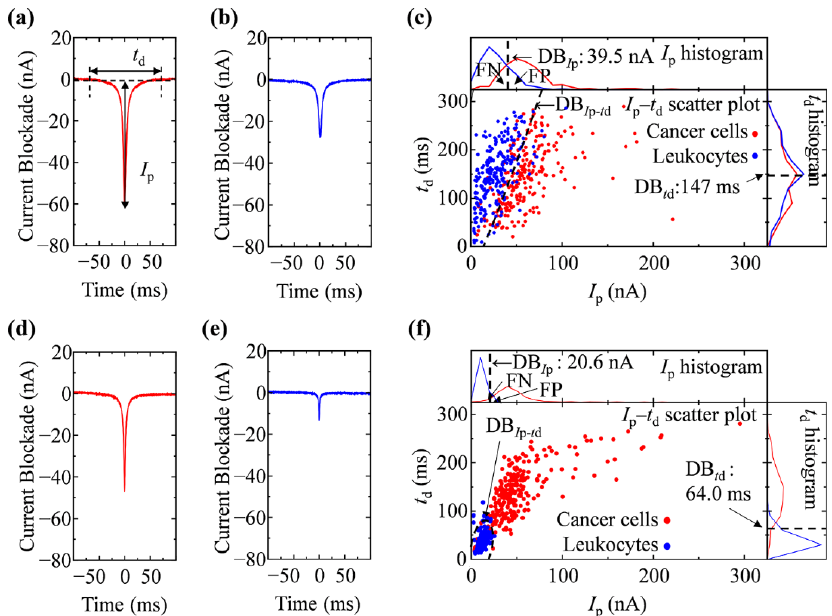
Figure 3. Electric current measurement by RPM. A typical waveform of the ionic current blockade by RPM was observed for ( a ) a cancer cell and ( b ) leukocytes in 1.0 × PBS. ( c ) The histogram of I p and t d , scatter plot of I p – t d , and the decision boundary for these cells. A typical waveform of the ionic current blockade by RPM was observed for ( d ) a cancer cell and ( e ) leukocytes in 0.5 × PBS. ( f ) The histogram of I p and t d , scatter plot of I p – t d , and the DBs for these cells.